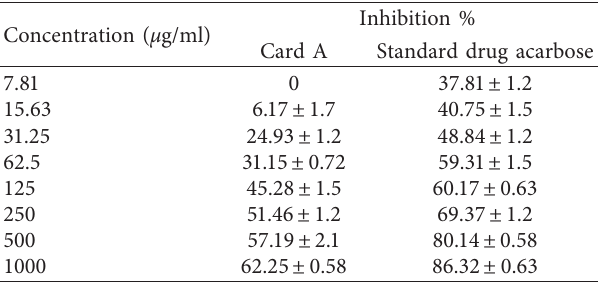
Data are represented as mean ±